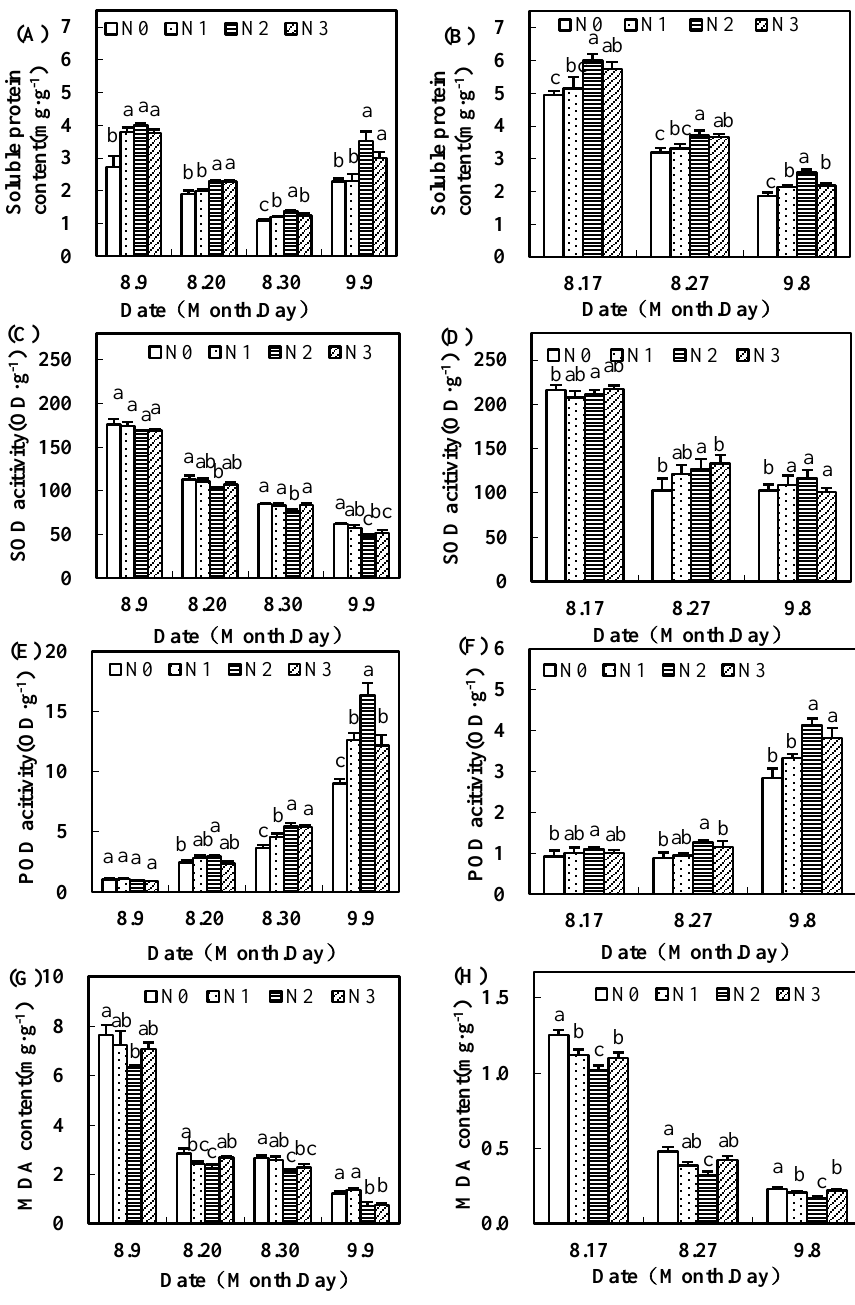
Figure 4. Effects of nitrogen fertilizer on soluble protein content ( A , B ), SOD activity ( C , D ), POD activity ( E , F ), and MDA content ( G , H ) in inner seeds of cotton upper fruiting branches surveyed in the Yellow River Basin of China in 2011 and 2012.